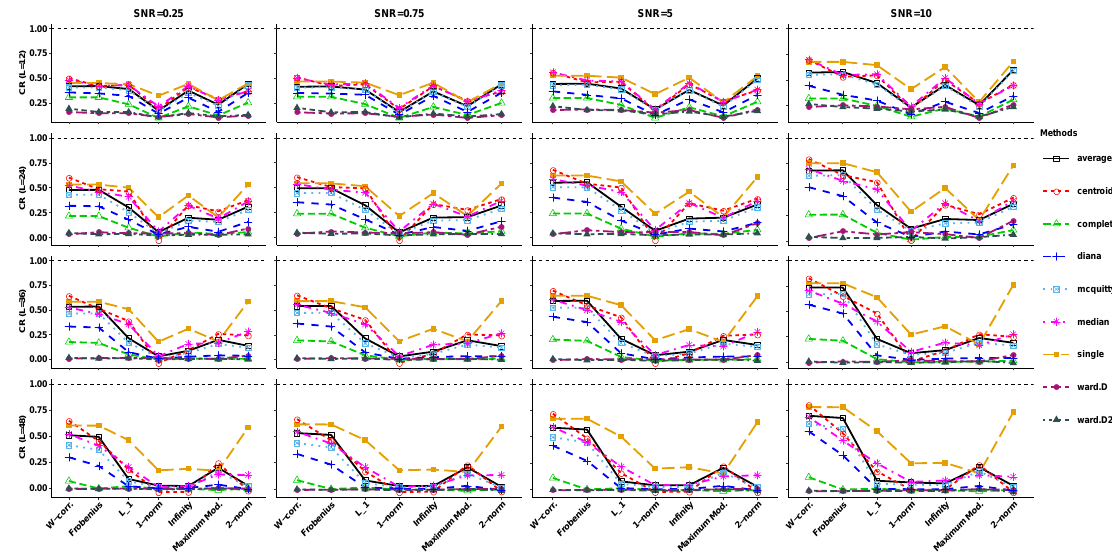
Figure 7. CR index for the exponential + sine series (case